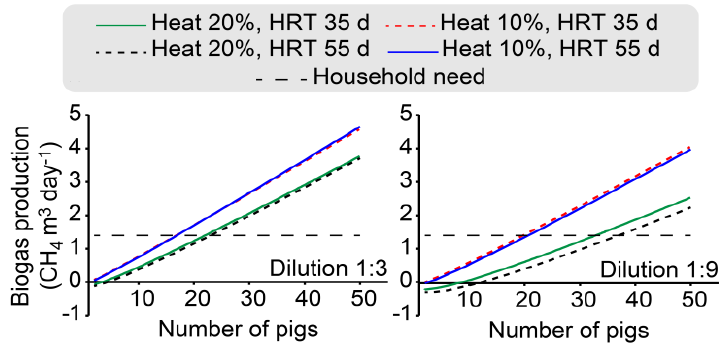
Figure 7. Effect of the number of animals on biogas delivery to the household when the digester is heated to 35 °C with solar energy and biogas. Biogas contributes 10% and 20% of the digester heat needed during periods with little or no solar heating, and the biogas boiler has an efficiency of